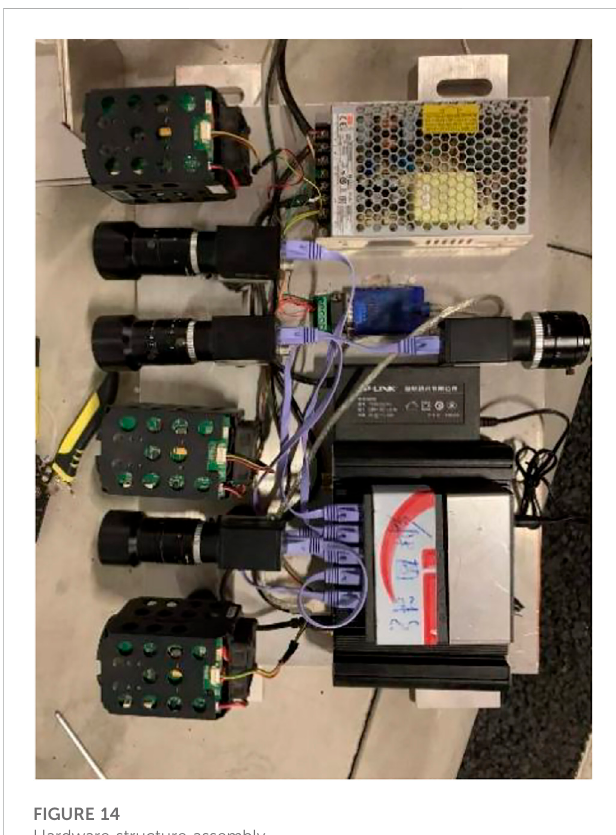
FIGURE 14 Hardware structure